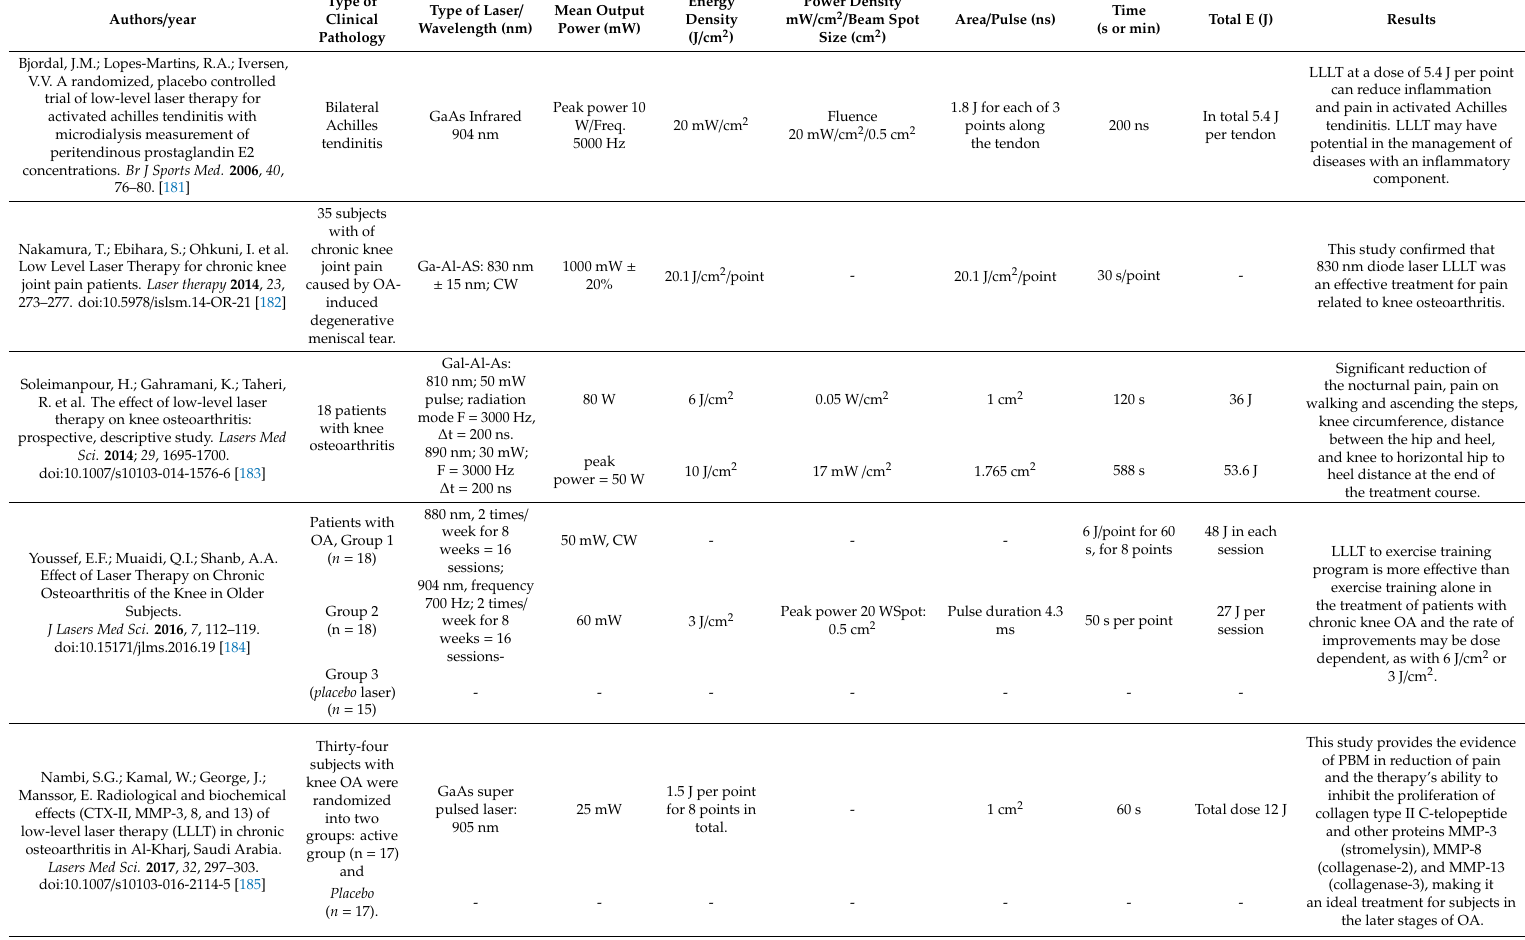
Table 2. Clinical e ff ects of PBM on various inflammatory pathologies and associated